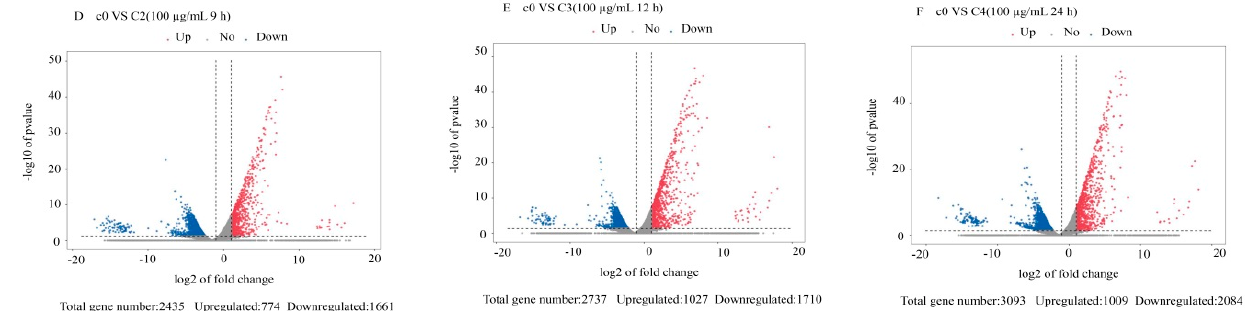
Figure 2. Volcanic map of DEGs in M. oryzae after treatment with citral at different concentrations. ( A ) Volcanic map analysis of DEGs in M. oryzae after treatment with citral (50 µ g/mL) for 9 h. ( B ) Volcanic map analysis of DEGs in M. oryzae after treatment with citral (50 µ g/mL) for 12 h. ( C ) Volcanic map analysis of DEGs in M. oryzae after treatment with citral (50 µ g/mL) for 24 h. ( D ) Volcanic map analysis of DEGs in M. oryzae after treatment with citral (100 µ g/mL) for 9 h. ( E ) Volcanic map analysis of DEGs in M. oryzae after treatment with citral (100 µ g/mL) for 12 h. ( F ) Volcanic map analysis of DEGs in M. oryzae after treatment with citral (100 µ g/mL) for 24 h. Red represents upregulated significantly differentially expressed genes, blue represents downregulated significantly differentially expressed genes, and gray dots represent non significantly differentially expressed genes.